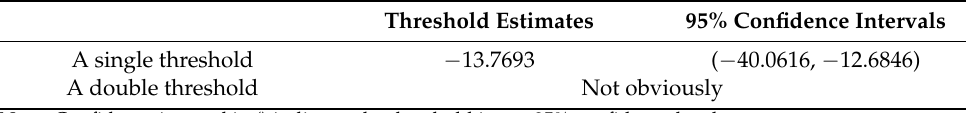
Table 5. Threshold estimates and confidence intervals.